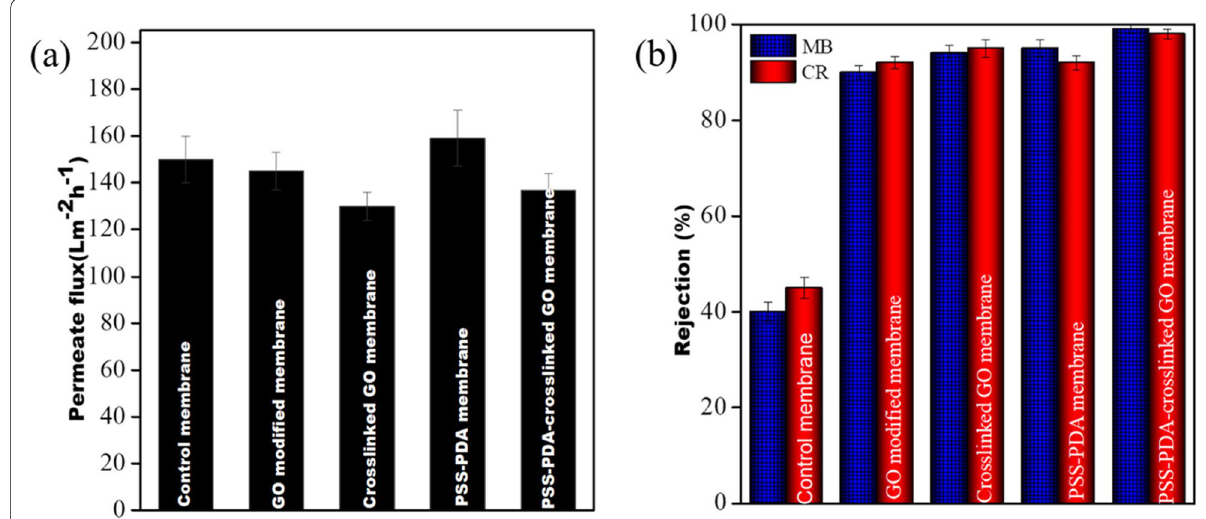
Fig. 9 Pure water flux ( a ) and rejection of dyes ( b ) by membranes at 0.413